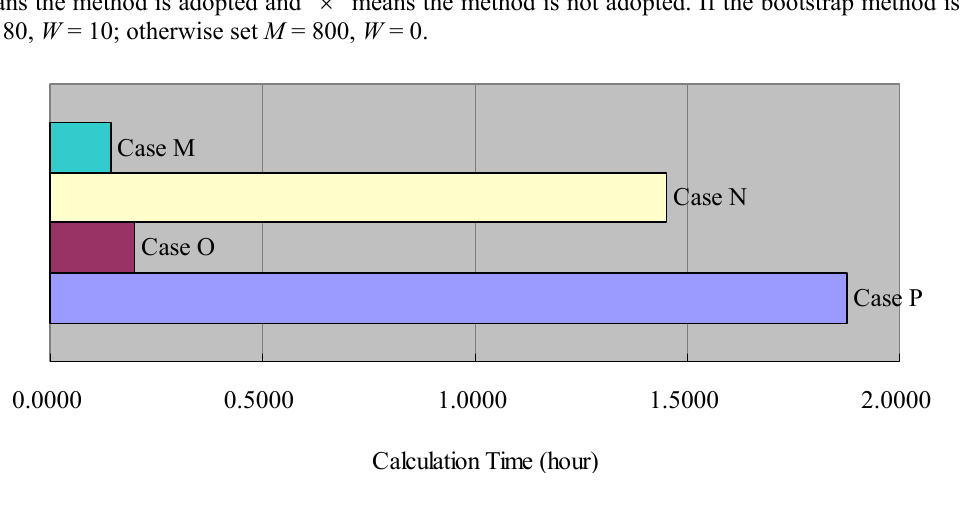
Figure 4. The comparison of calculation